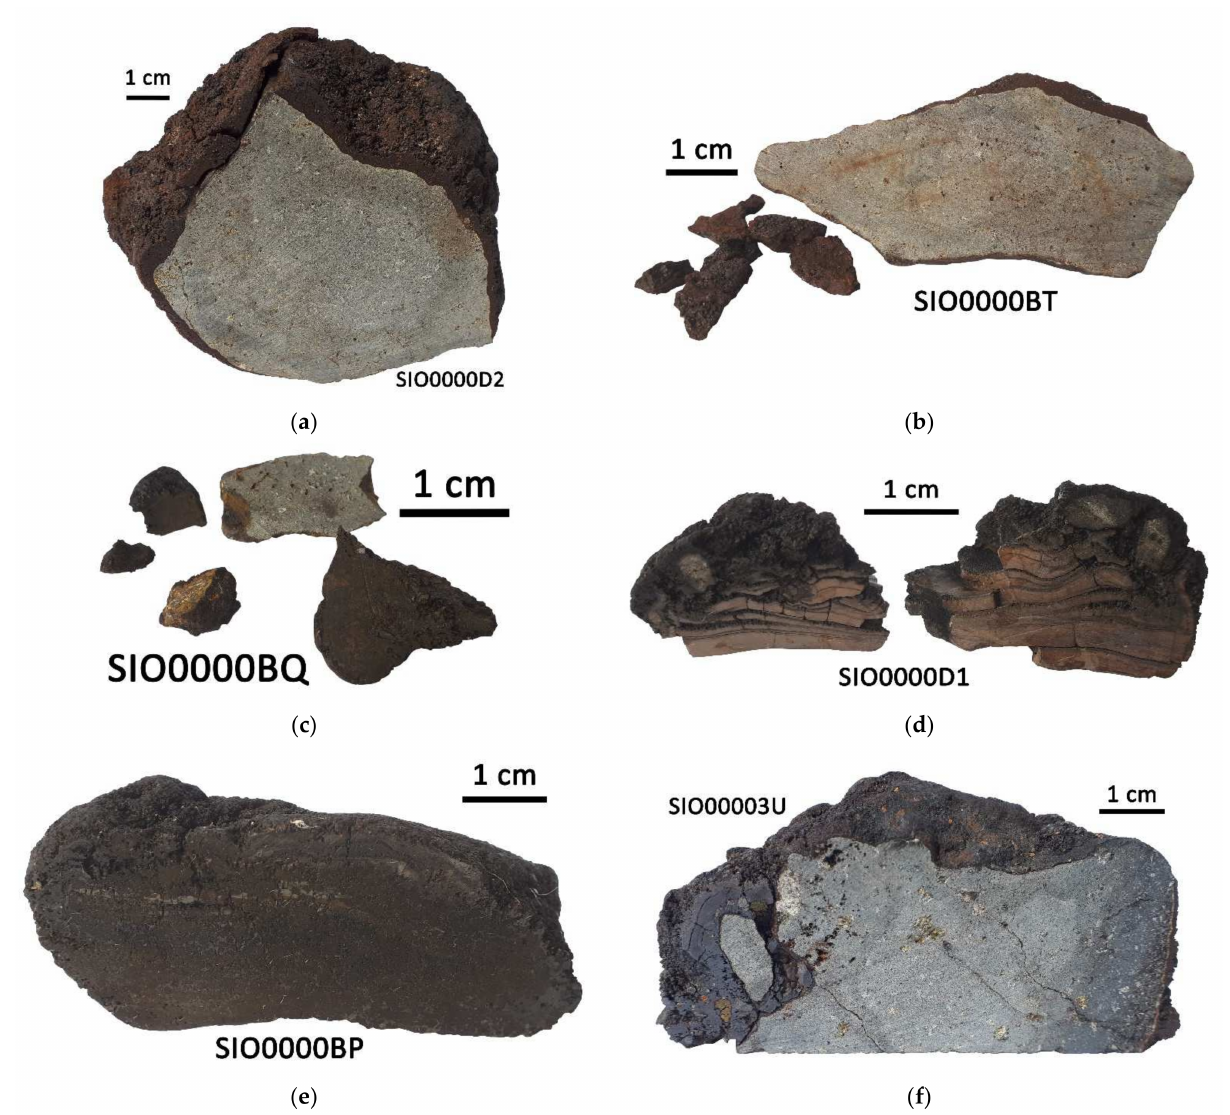
Figure 2. Textural types of Fe-Mn crusts from the C-NSC: Type 1: ( a ) A non-laminated botryoidal crust on a thick basalt substrate; ( b ) Thin non-laminated crust on a basalt substrate. Crust fractured during transport; ( c ) A non-laminated botryoidal crust on a basalt substrate. The crust fractured during transport. Type 2: ( d ) Layered crust collected without substrate. ( e ) The thickest studied crust sample, with slightly visible layering. Type 3: ( f ) Transitional crust formed on an intensely altered basalt substrate with a slightly visible